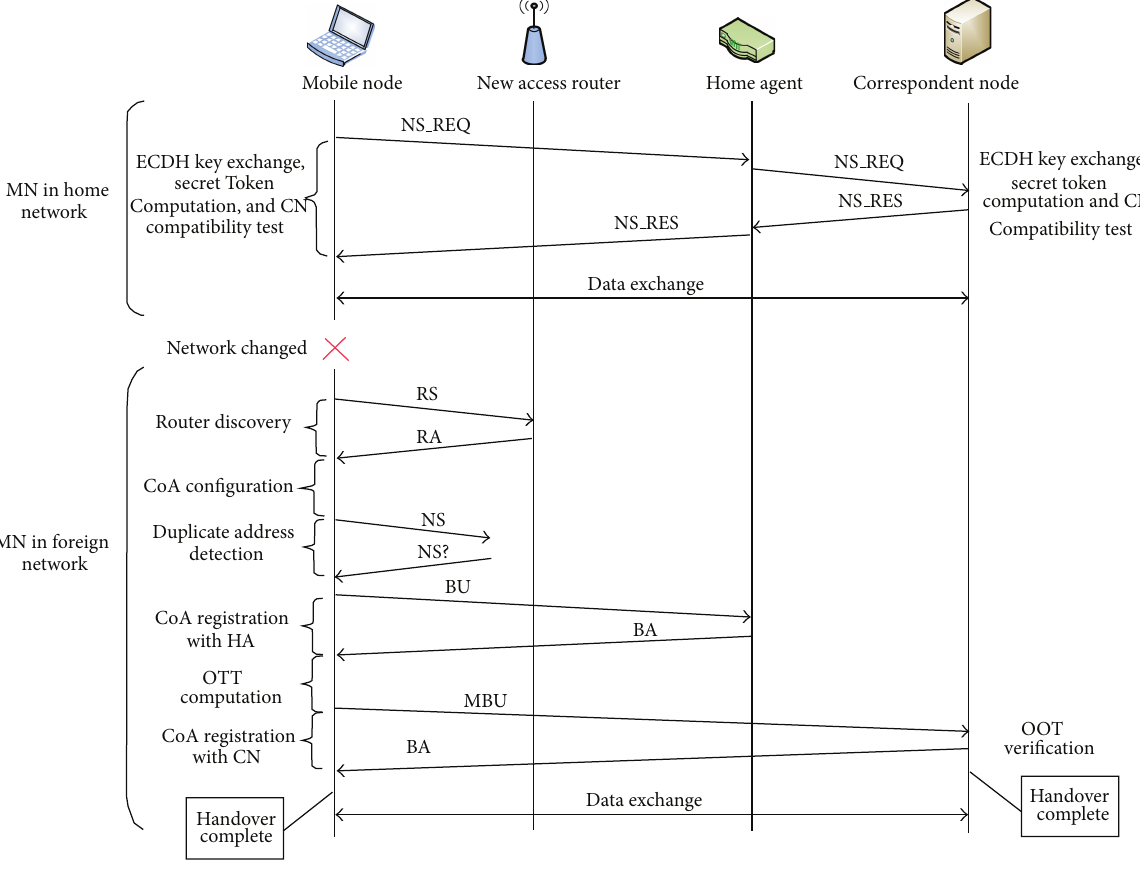
Figure 6: Proposed enhanced TOTP-RO sequence flow.